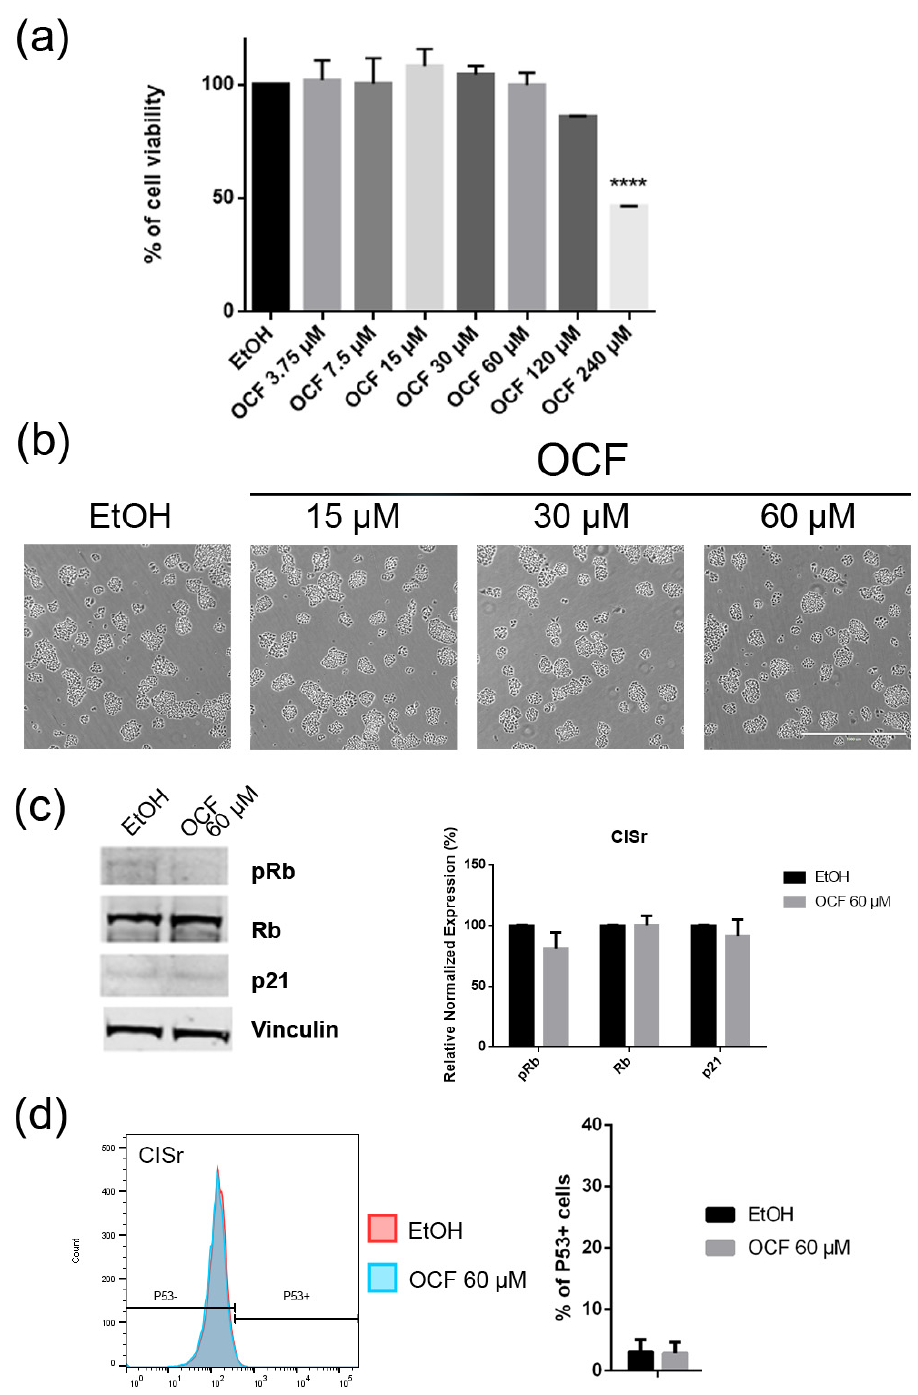
Figure 8. Effects of different doses of OCF on the CISr cells. CISr cells treated for 72 h with vehicle or with different doses of the OCF, were analyzed through a MTT assay ( a ); pictures were obtained with an inverted microscope at 4× magnification ( b ); representative western blot analysis of p-Rb, Rb, p21 and vinculin levels in the CISr cells treated with vehicle or with 60 µM dose of the OCF for 24 h and the corresponding densitometry ( c ). Flow cytometry plots for the p53 staining and the corresponding histograms ( d ). Data are presented as mean ± SD of three independent experiments. Results of the representative experiments are shown. ( a ) One-way ANOVA Dunnett’s multiple comparisons test; ( c , d ) Two-way ANOVA Sidak’s multiple comparisons test. **** p <